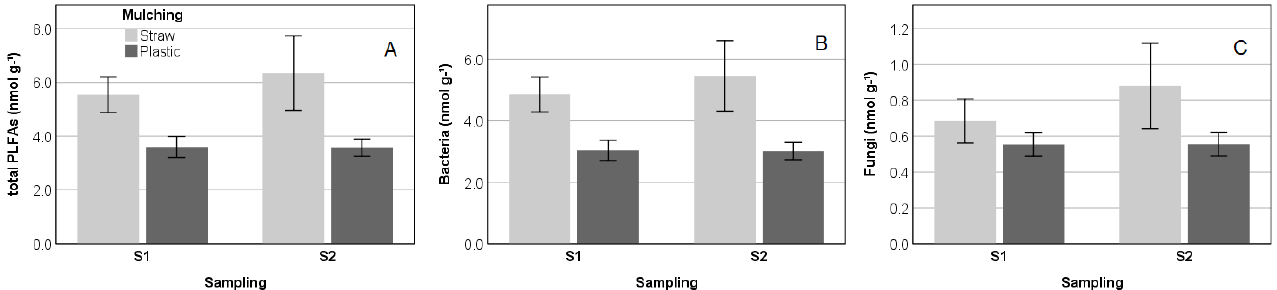
Figure 1. Abundance of PLFA biomarkers in soil samples differentiated by mulching system